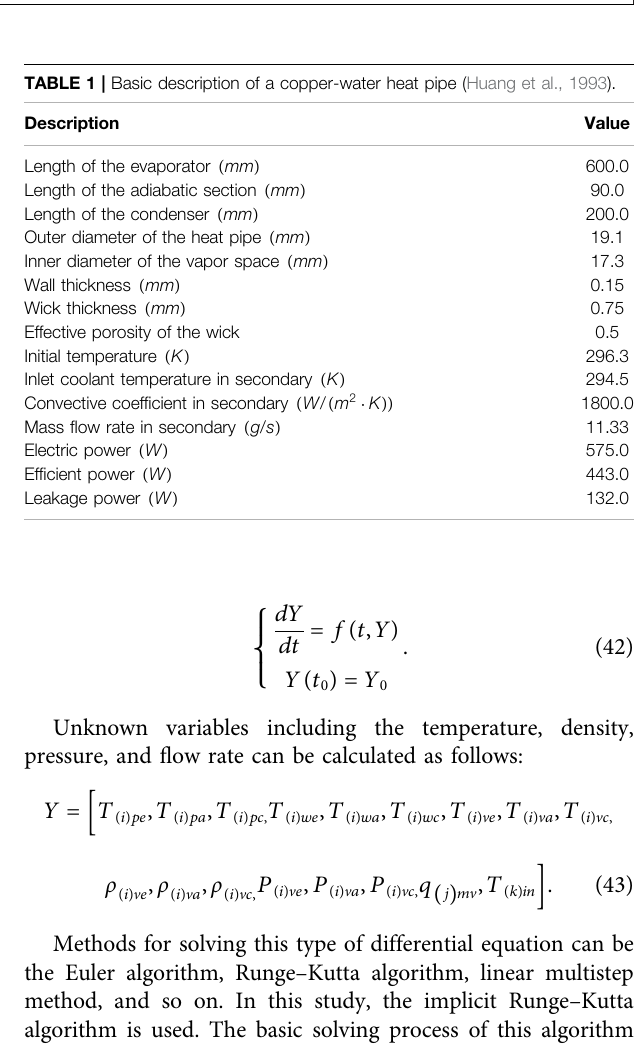
FIGURE 7 | Pumping head of the capillarity.